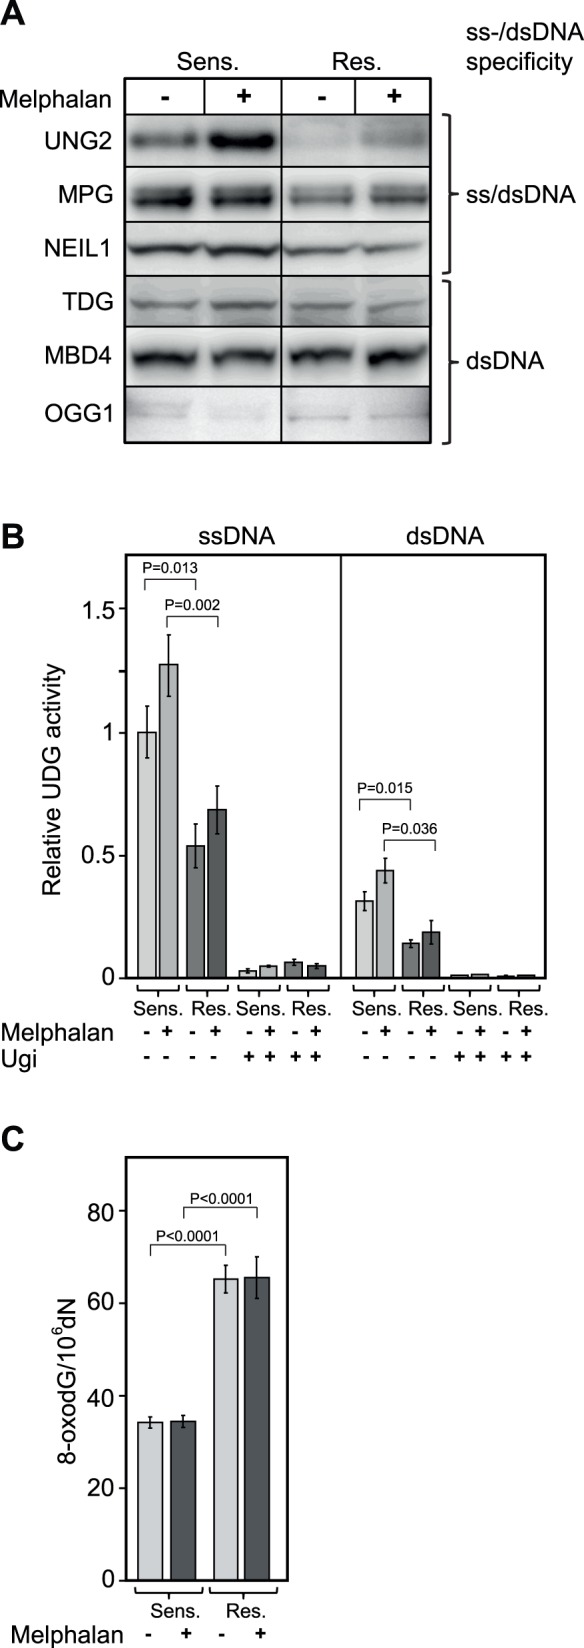
DNA glycosylases with dual ss/dsDNA substrate specificity are downregulated in Melphalan-resistant cells.Levels of DNA glycosylases (A), relative UDG activities (B) and genomic 8-oxodG-content in sensitive and resistant cells prior and after exposure to 50 µM Melphalan. Western blot analysis revealed downregulation of UNG2, MPG and NEIL1 (dual ss/dsDNA-specific glycosylases) in the Melphalan-resistant cells compared to sensitive cells while this was not observed for the dsDNA-specific glycosylases TDG, MBD4 and OGG1, the latter barely above the detection level in the cells (A). In agreement with UNG2 protein levels, activity assays showed that uracil excision activity was significantly higher in sensitive cells against [3H]dUMP-containing ss- and dsDNA substrates. Moreover, high dose Melphalan mediated an apparent increase in UDG activity in both cell lines, although this was only significant (P<0.05) for the resistant cells. Addition of the UNG-specific inhibitor Ugi to the reactions demonstrated that the observed reduced uracil-excision activity in the resistant cell line was mainly accounted for by reduction of UNG-activity. Each bar constitutes an average from four independent experiments, each run in triplicate, with standard deviations as demonstrated. P-values were calculated using unpaired Student t-test (B). A twofold increased steady state level of genomic 8-oxodG was found in the resistant compared to the sensitive cells. Each bar constitutes and average from three independent experiments with standard deviations as indicated (C).